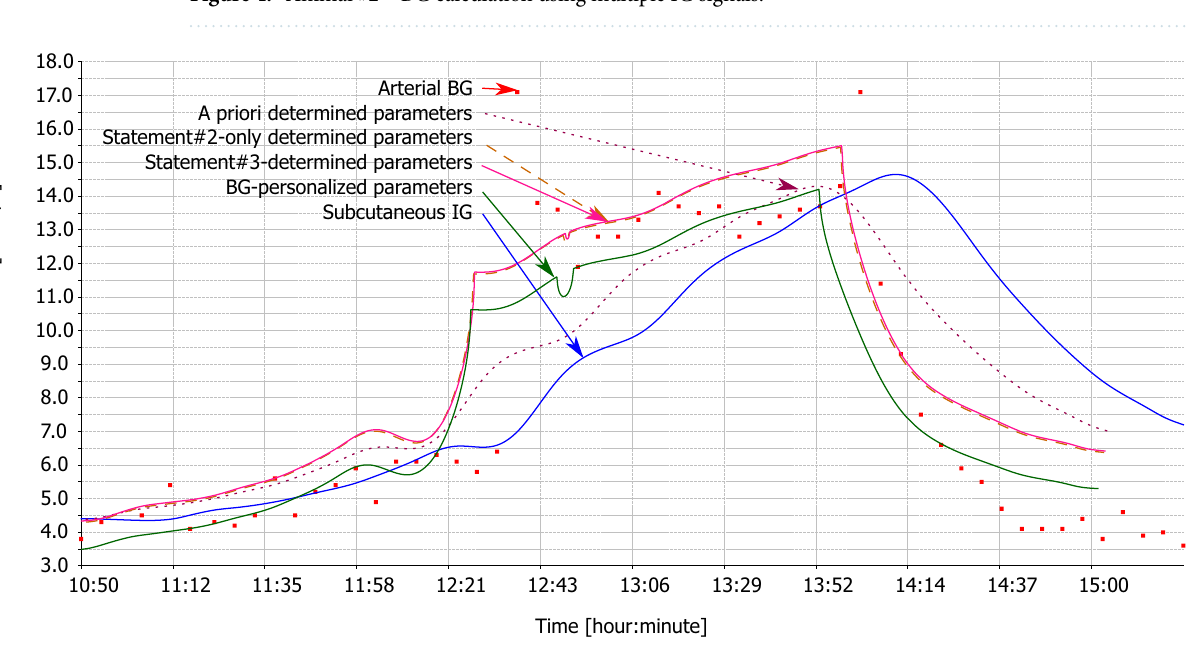
Figure 5. Animal #2 – BG calculation using individual IG